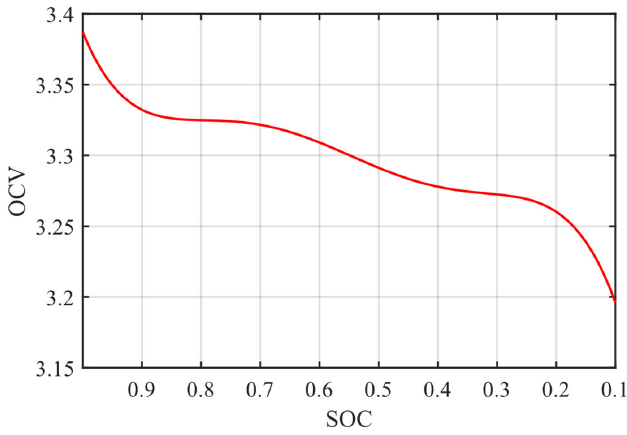
Figure 4. OCV-SOC curve.